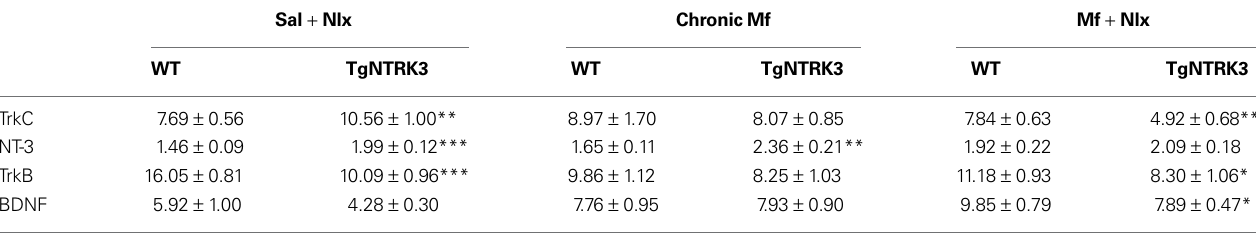
Table 1 | In situ hybdridization of TrkC, TrkB and their ligands after chronic morphine administration and precipitated withdrawal.